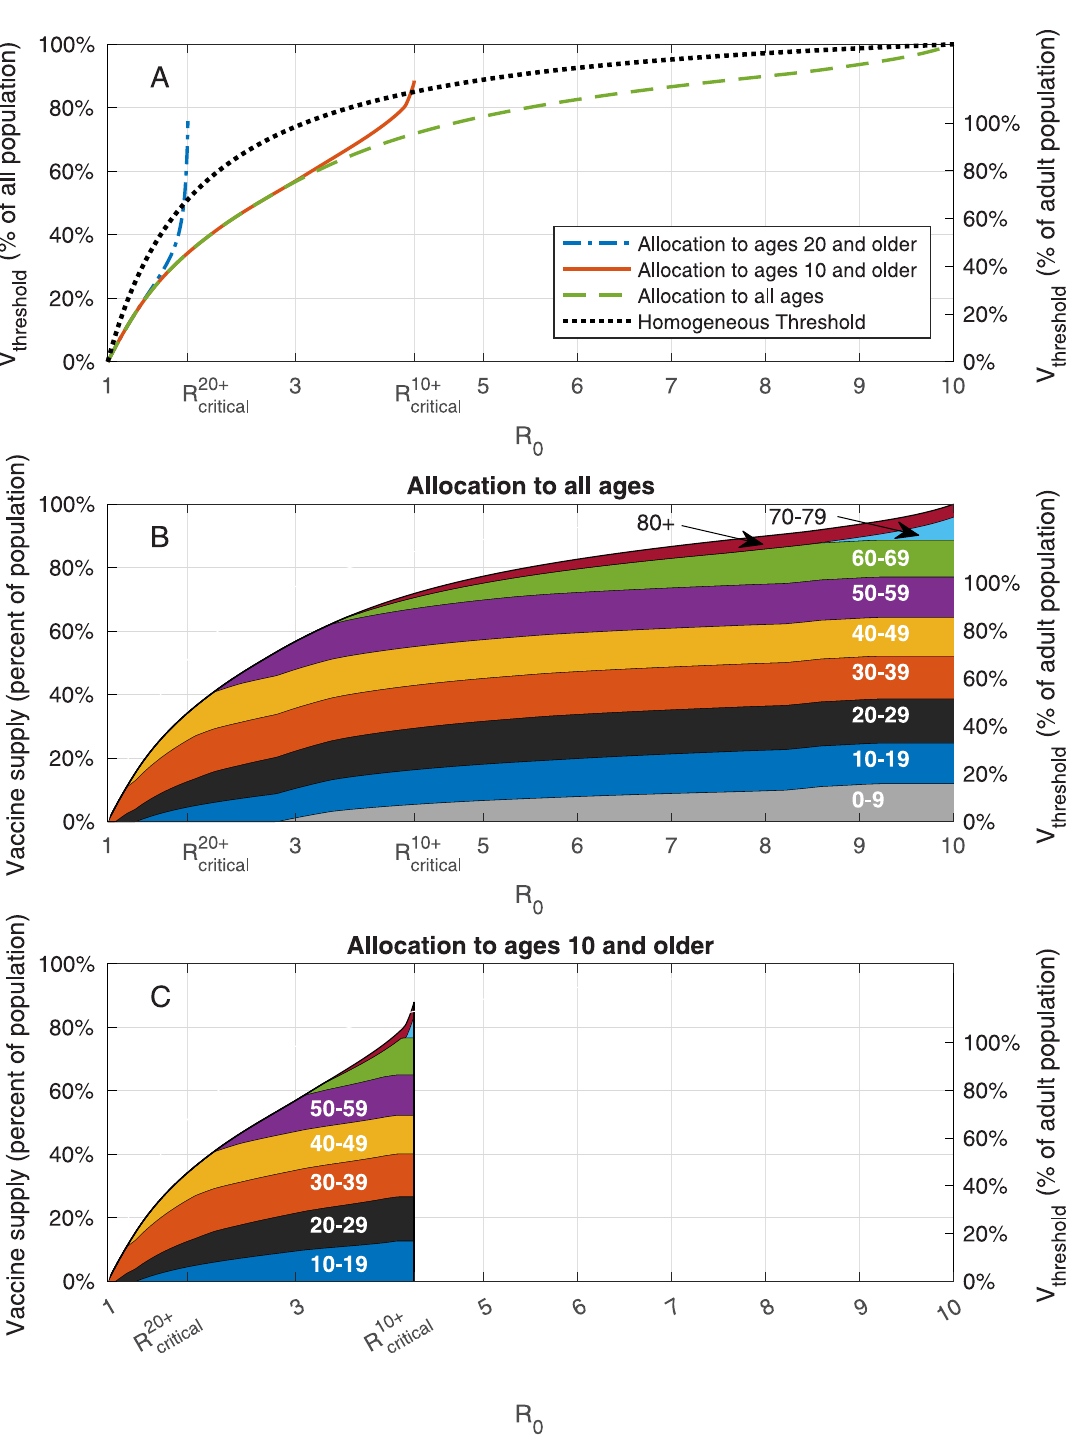
Fig 2. Vaccination coverage required for herd immunity. A: Vaccine coverage V threshold required to achieve herd immunity threshold as a function of the reproduction number R 0 for the USA demography and contact structure where R 20 þ beproduction numbers at which herd immunity cannot be achieved without vaccination of age groups 0 − 19 and 0 − 9, respectively. B: Vaccine allocations at which herd immunity is achieved at minimal vaccine coverage and when all the population is eligible for vaccination. C: Same as B, but when ages ten and older are eligible for vaccination.